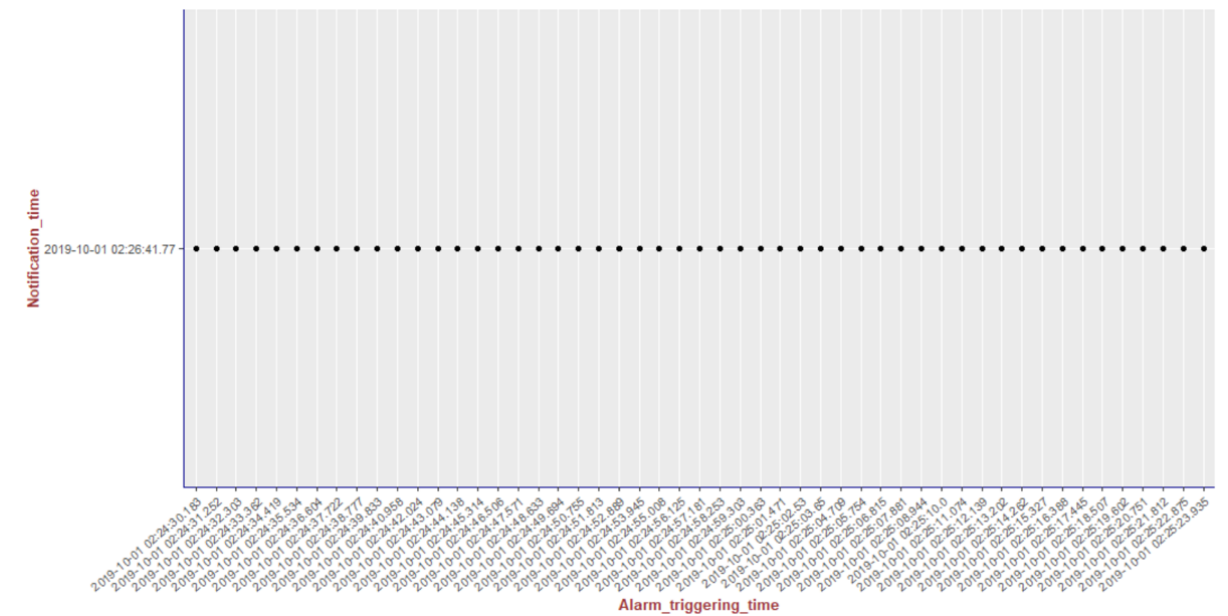
Figure 13. Illustration of the results of the alarm triggering and delivery processes related to the patient monitored in our experiment 5 (PatientID=5).